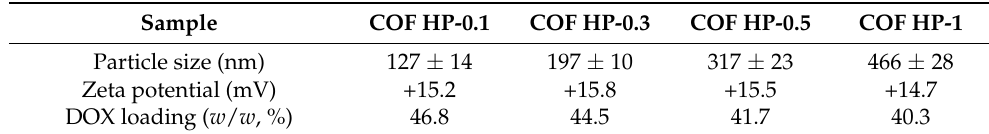
Table 2. The particle size, zeta potential, and DOX loading capacity of COF HP-0.1, COF HP-0.3, COF HP-0.5, and COF HP-1.